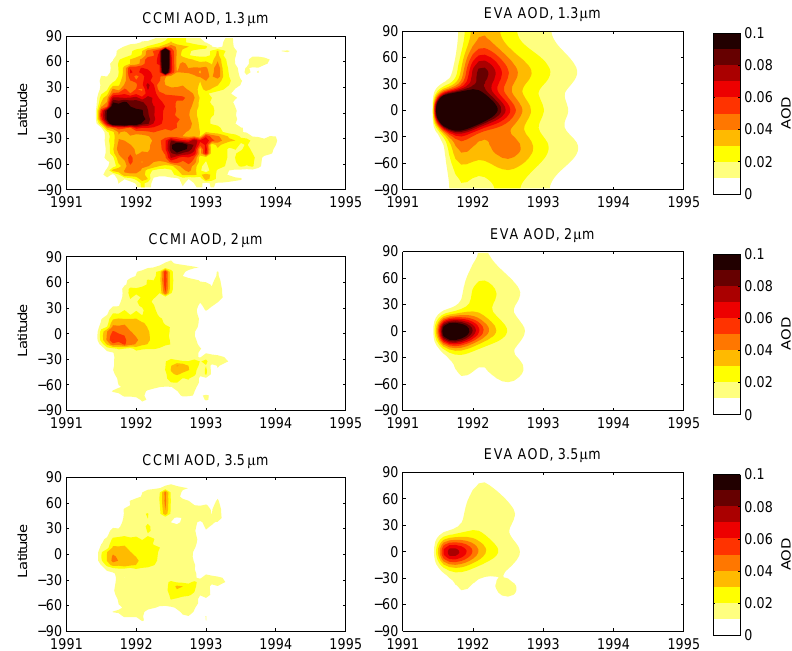
Figure 7. AOD after the Pinatubo eruption for selected wavelengths from (left) CCMI and (right) EVA.